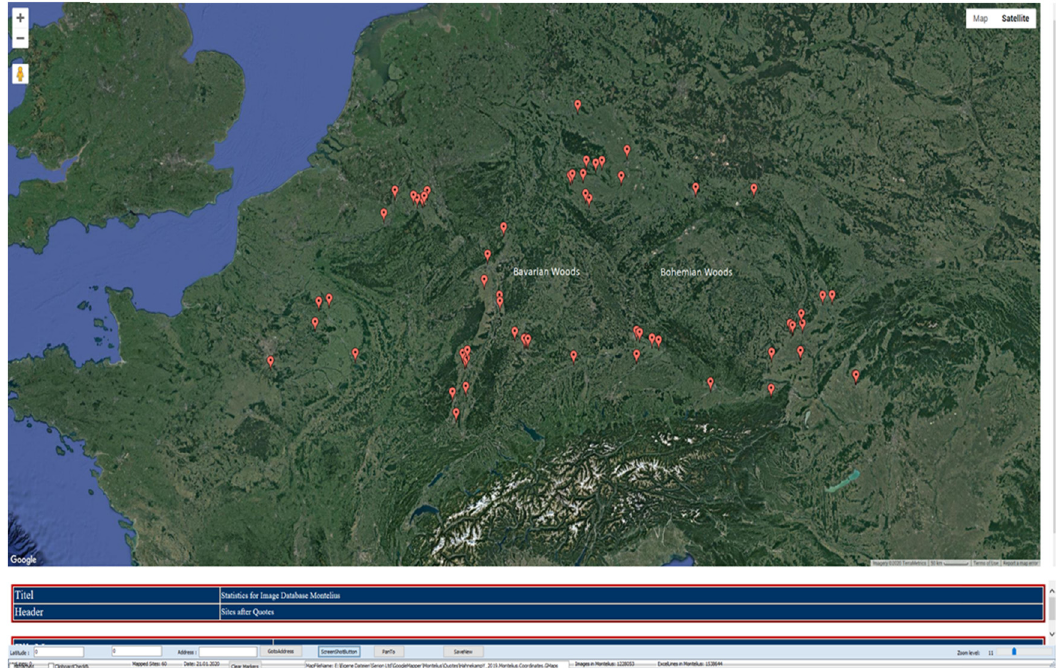
Figure 3: Superregional distribution map of Linear Pottery cemeteries, created with the GoogleMapper function of Serion Ltd. ( Hahnekamp, 2020, p. 307, Figure App. 1 )